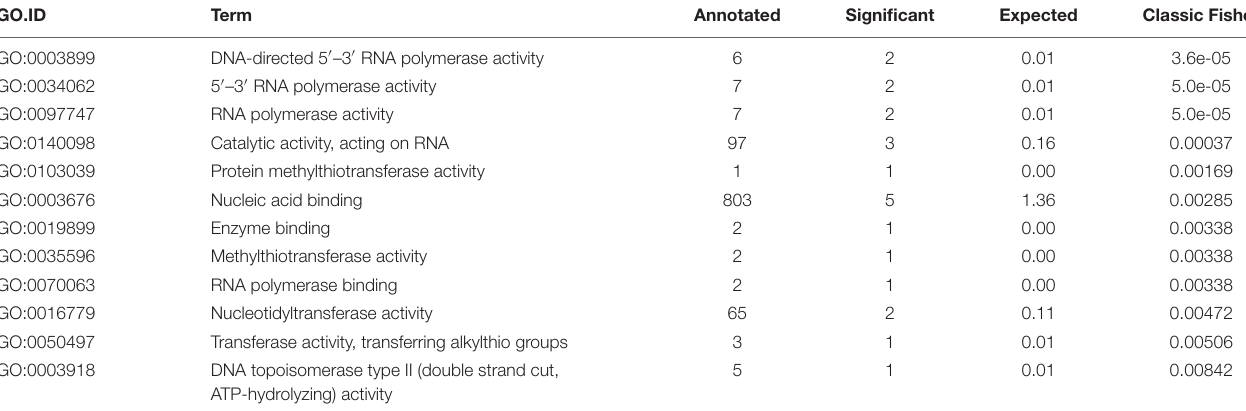
TABLE 6 | Molecular function (MF) gene ontology (GO) enrichment